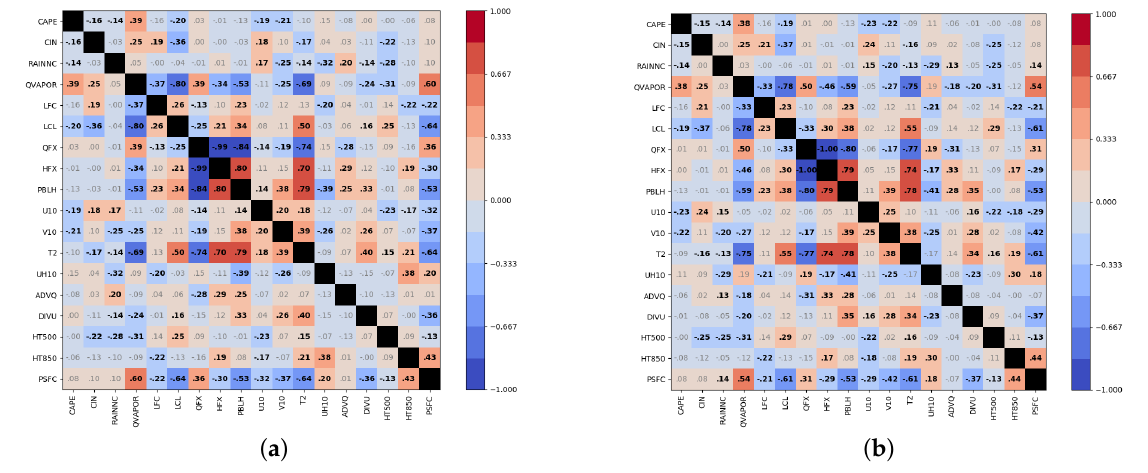
Figure 8. Spatial differences between the irrigated parameterization (( a ) Channel) and the control ( b ) run, averaged over the irrigated field and correlated with each other. The numbers highlighted in bold are the correlations that are significant ( p <